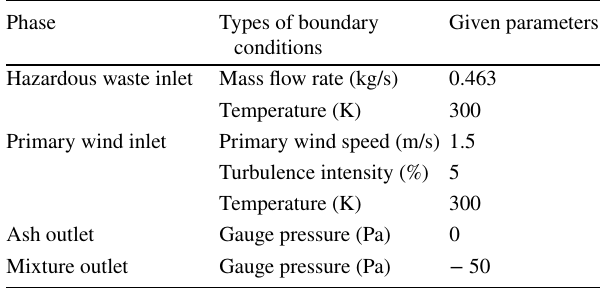
Table 2 Operating conditions of each reactor Operating conditions Reactor modules